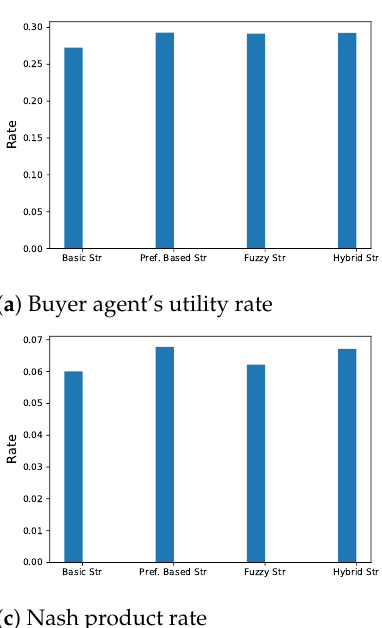
Figure 10. Utility and Nash product rates per agreement with small overlap and random